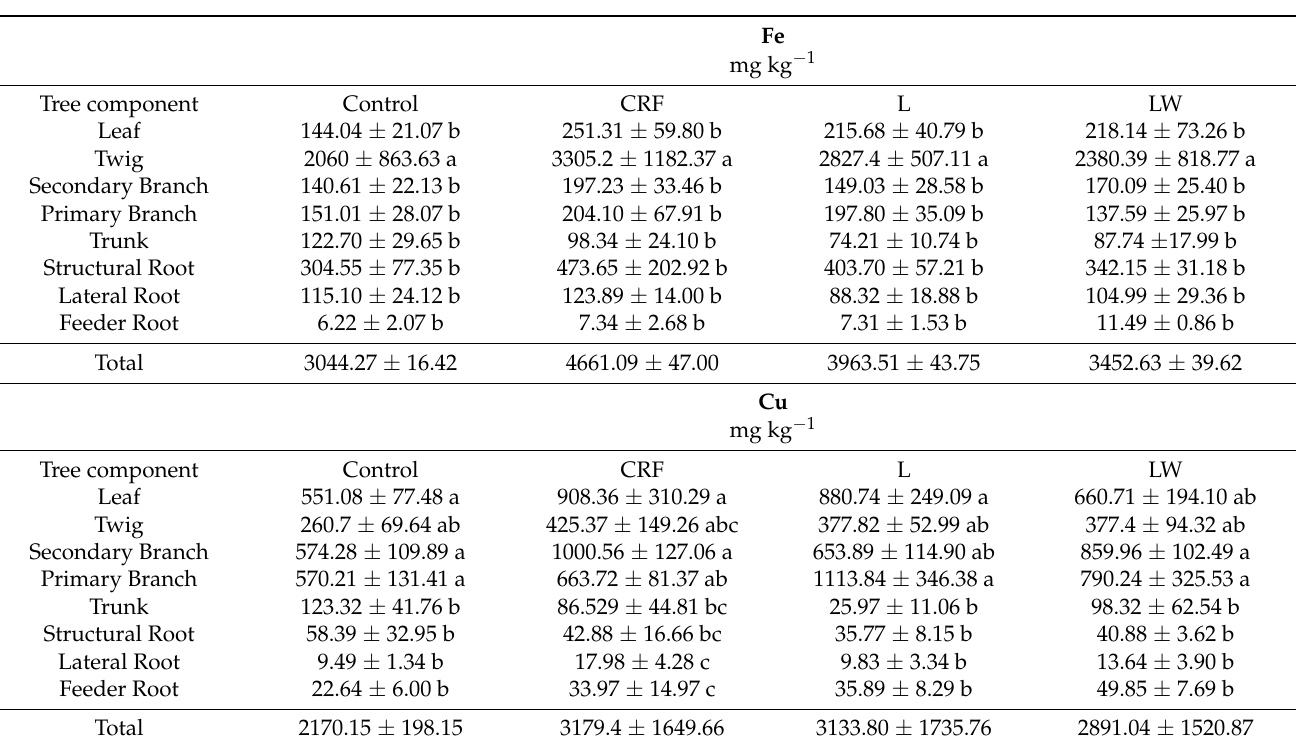
Table 4. Iron (Fe) and copper (Cu) contents per individual components and tree total. Six-year- old Huanglongbing-affected ‘Ruby Red’ grapefruit trees grafted on sour orange rootstock were used. Treatments consisted of two liquid (L and LW) and two granular fertilizers (Control and controlled-release fertilizer (CRF)). A Kruskal–Wallis test was used in combination with a Tukey’s honestly significant difference (HSD) test to identify and test significant differences in total nu- trients in individual tree components (differences signified by letters). Data represents means ( n = 4) ± standard error. Fe mg kg − 1